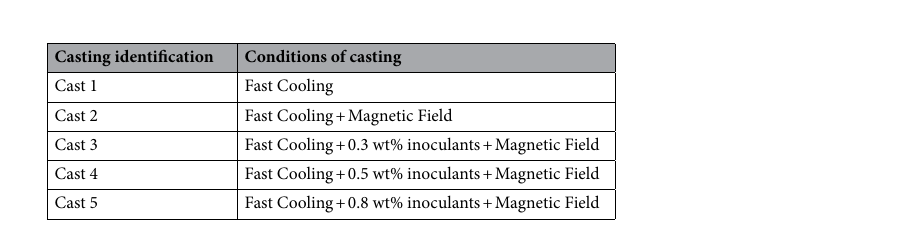
Table 2. Casting conditions for various slab